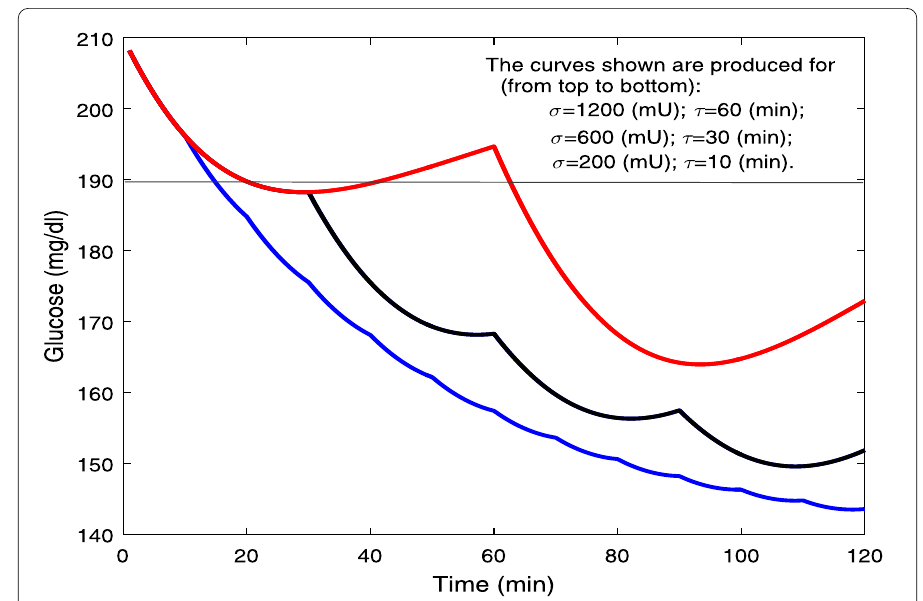
Figure 2 Comparison of the profiles produced by model (2) with the same total insulin injection vs. different delivery periods